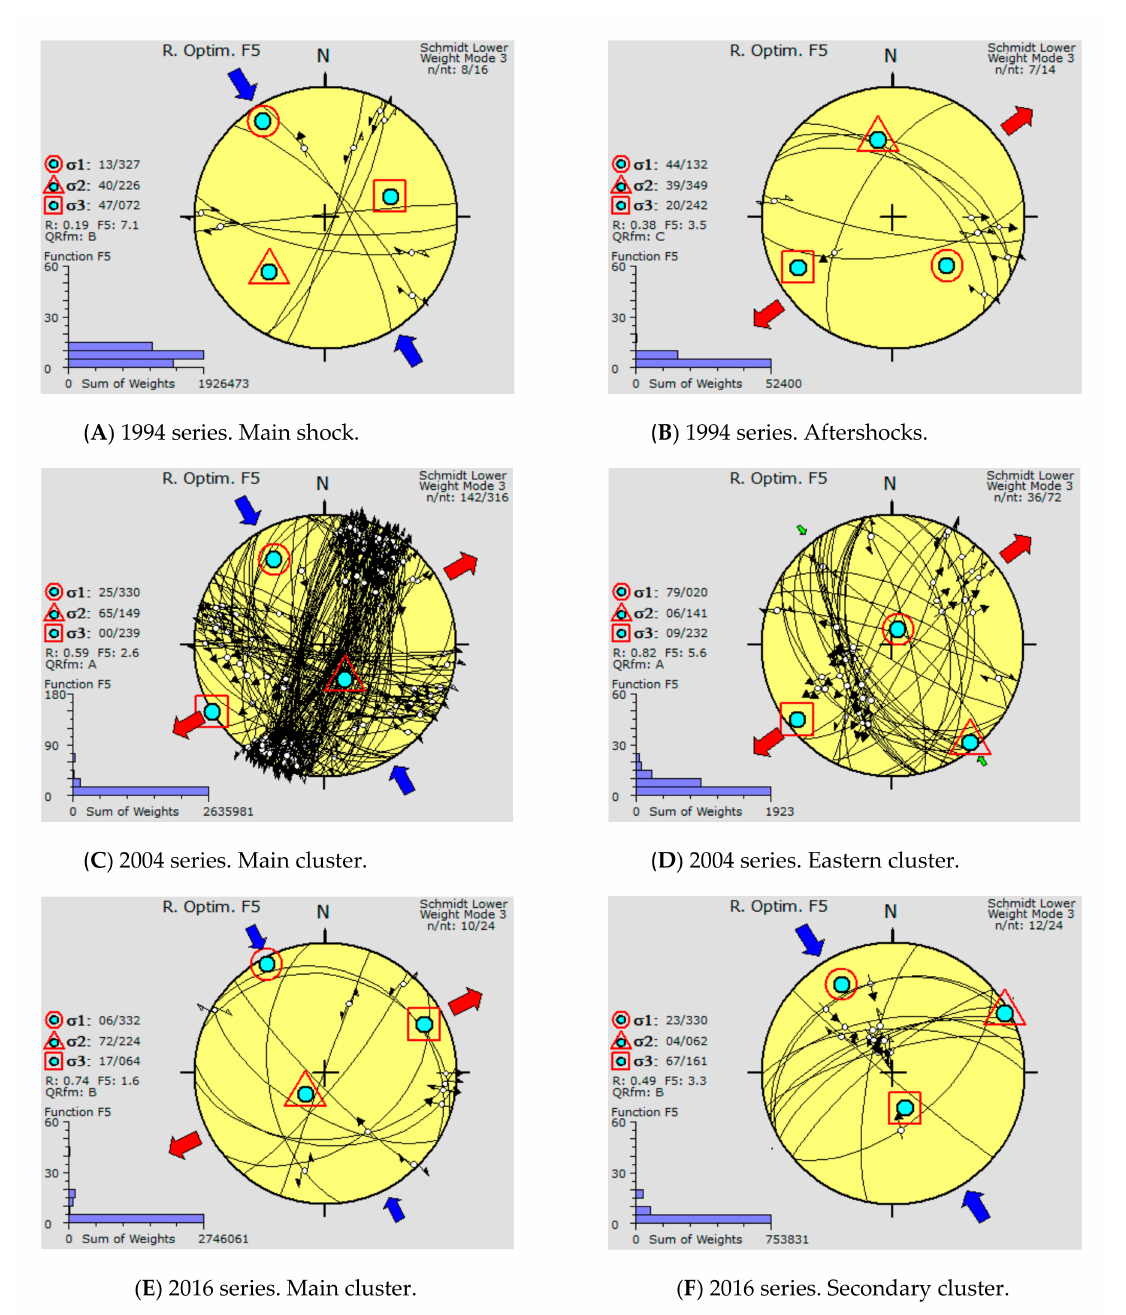
Figure 7. Stress regime computed from focal mechanisms. ( A ) For the 1994 mainshock, ( B ) for the 1994 aftershock sequence, ( C ) for the 2004 aftershock sequence, ( D ) for the ‘eastern cluster’ considered by [34], ( E ) for the 2016 ‘main cluster’ and ( F ) for the 2016 ‘secondary